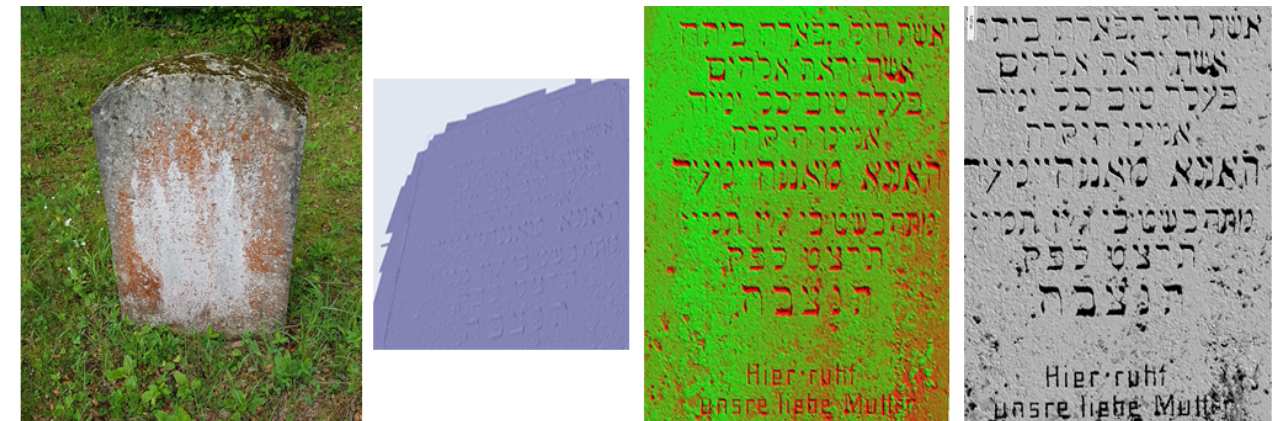
Figure 3 . Photogrammetry workflow example for reading faded inscriptions. From left to right: Image of typical gravestone with highly eroded inscription; 3D model; depth map; output image with readable